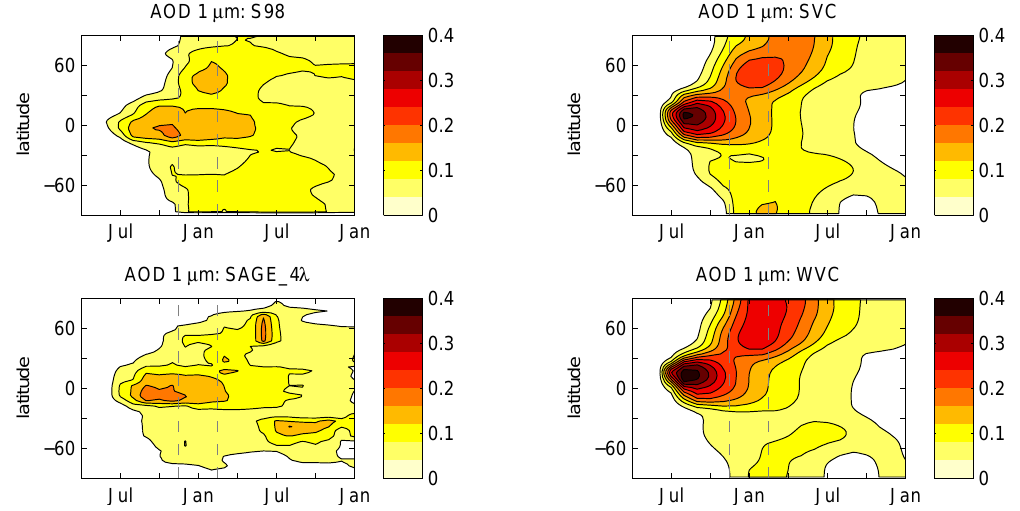
Figure 2. Zonal mean aerosol optical depth at 1µm for the Pinatubo eruption, (left) as reconstructed from observations producing the S98 and SAGE_4 λ forcing data sets and (right) based on MAECHAM5-HAM model simulations and composited according to strong (SVC) and weak (WVC) vortex states. Dashed vertical lines demarcate the DJF period of